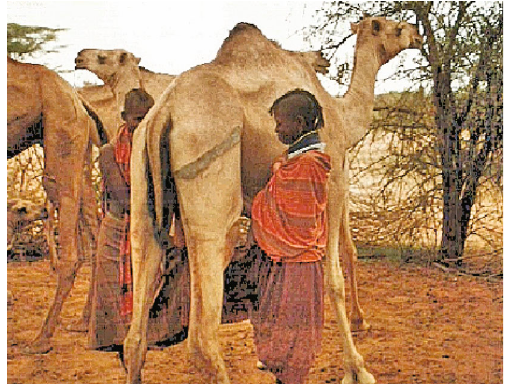
Figure 1: The Turkana breeds. Source: [17] (with permission from authors).